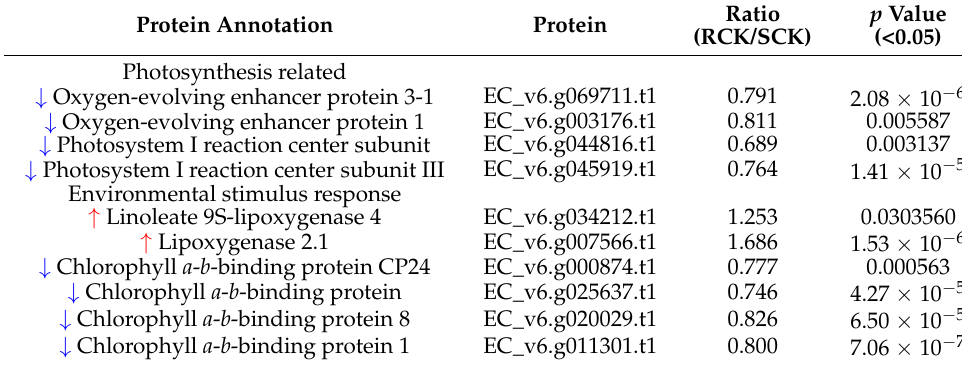
Table 1. The major differentially accumulated proteins between quinclorac-resistant and -sensitive (RCK vs. SCK) E. crus-galli . Protein Annotation